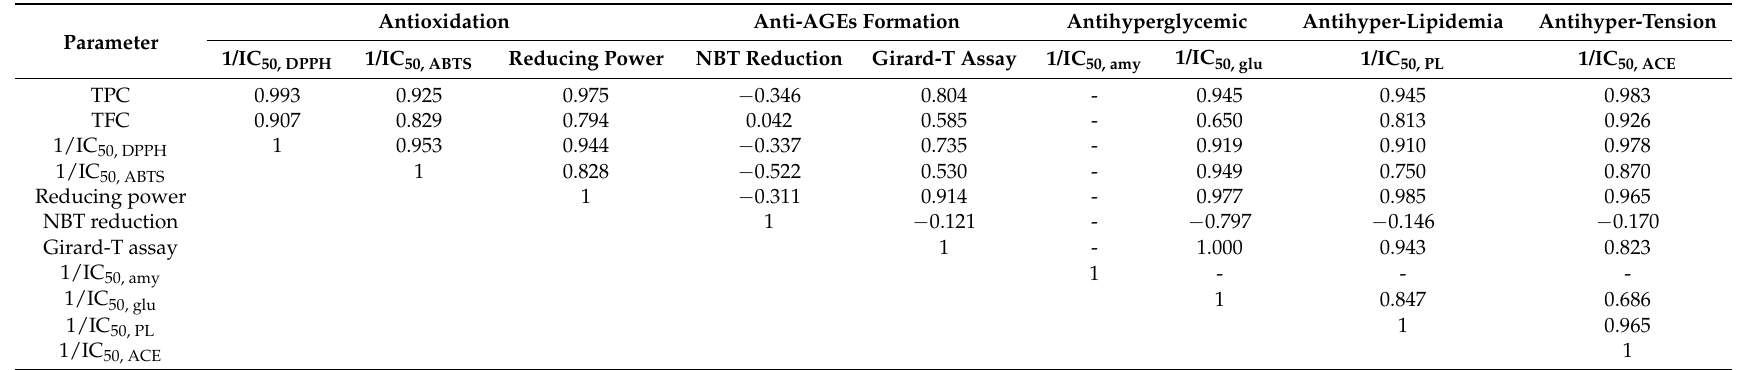
Table 1. Correlations between antioxidant, anti-AGEs formation, anti-hyperglycemic, antihyperlipidemia and antihypertension activities in S. orientalis extracts with their respective total polyphenols (TPC) and total flavonoids (TFC)